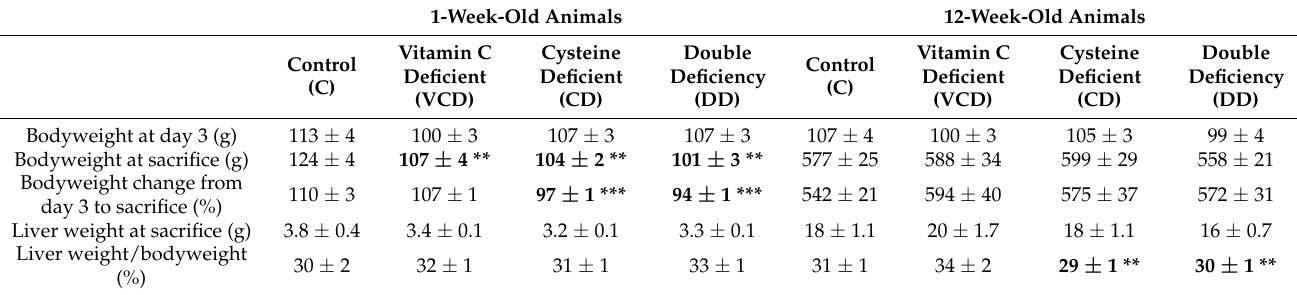
Table 2. Basal characteristics at 1 and 12 weeks of life depending on neonatal